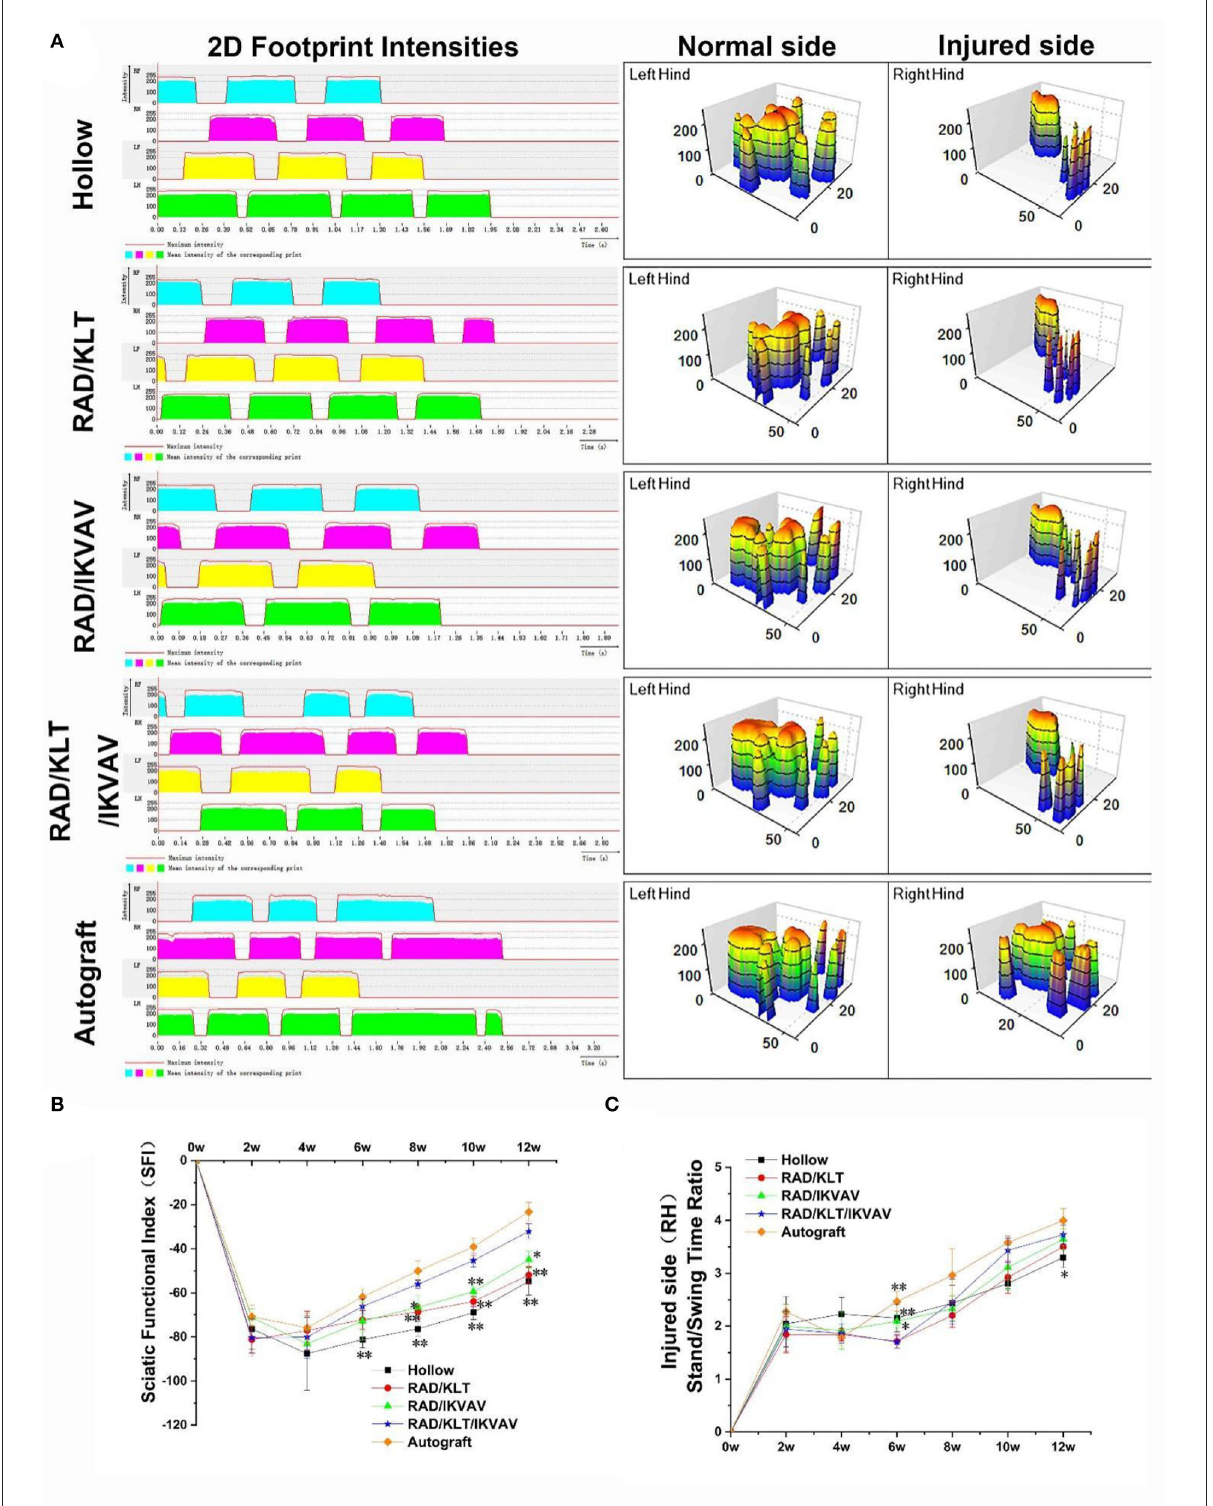
FIGURE9 Motor functional recovery at 12 weeks after implantation examined by CatWalk gait analysis. (A) Representative CatWalk analysis trace and 3D plantar pressure distribution of LH (contralateral) and RH (injured) from 5 different groups. LF, left front limb; LH, left hind limb; RF, right front limb; RH, right hind limb. Statistical analysis of the SFI values (B) and the stand/swing time ratio (C) . ( n = 5 approved runs for each group per time point). Data are expressed as means ± SEM. * p < 0.05, ** p < 0.01, one-way ANOVA with Tukey’s post-test or Dunnett T3’s